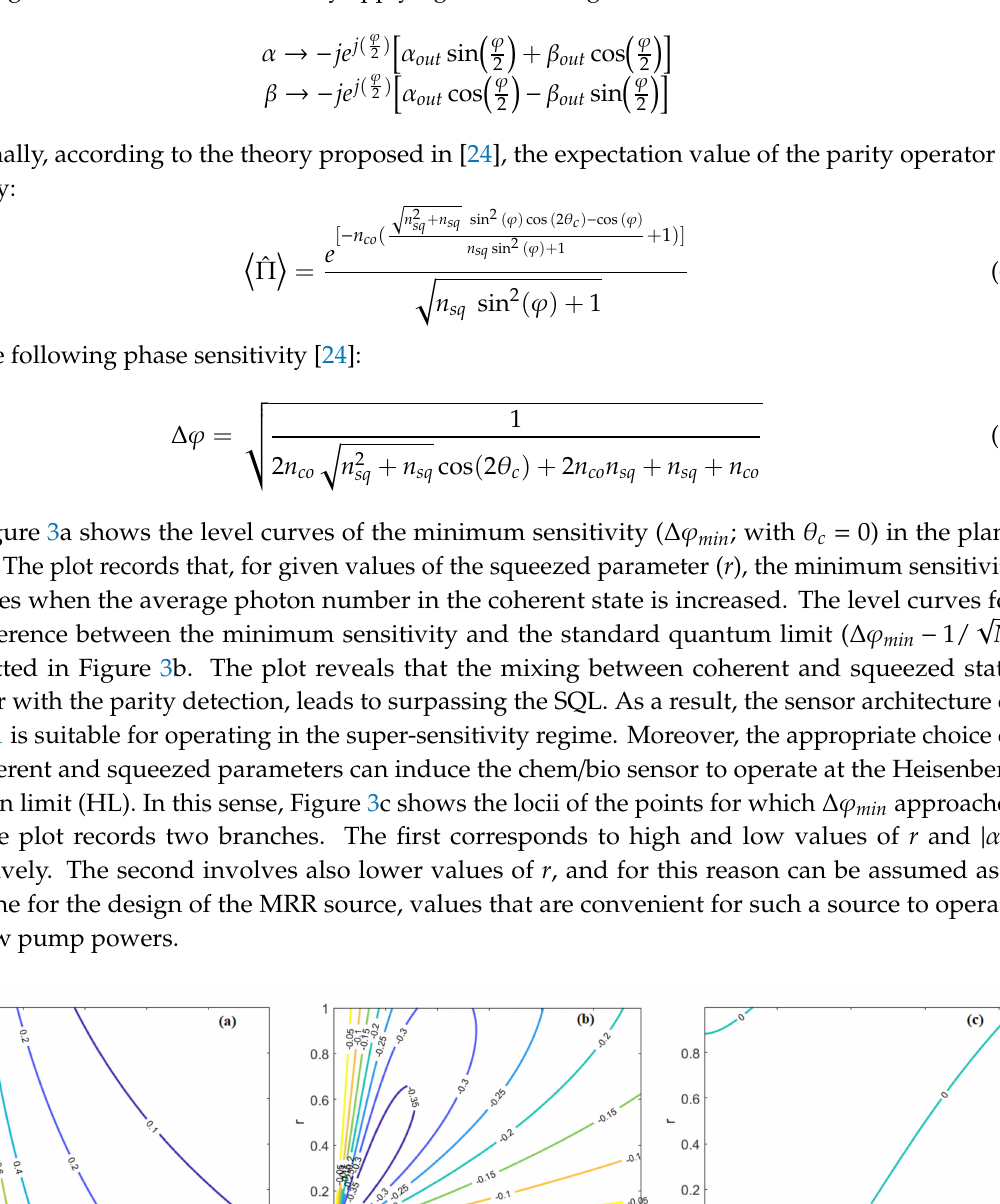
Figure 3. ( a ) Level curves of ∆ ϕ min in the plane ( | α 0 | , r ); ( b ) level curves of ( ∆ ϕ min − 1/ ( c ) locii of the points where ∆ ϕ min approaches